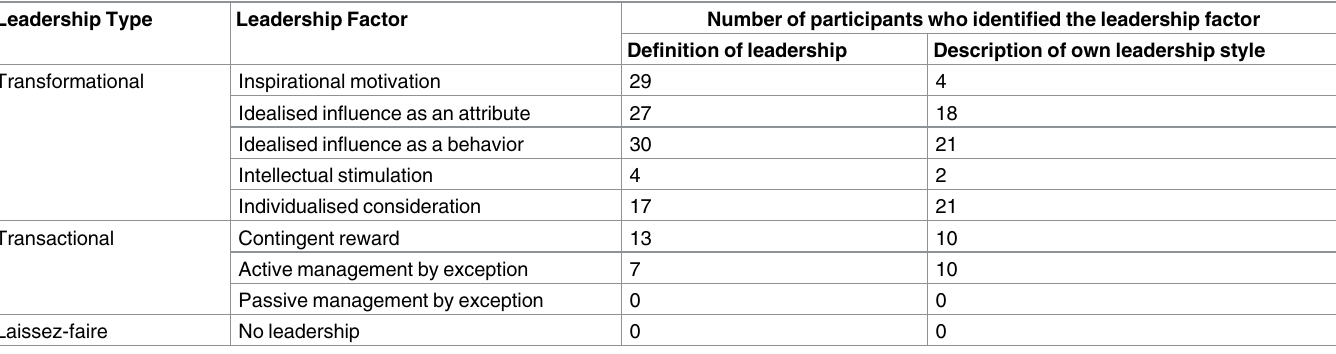
Table 4. Number of persons referring to each leadership factor in their definition of leadership and description of own leadership style. Leadership Type